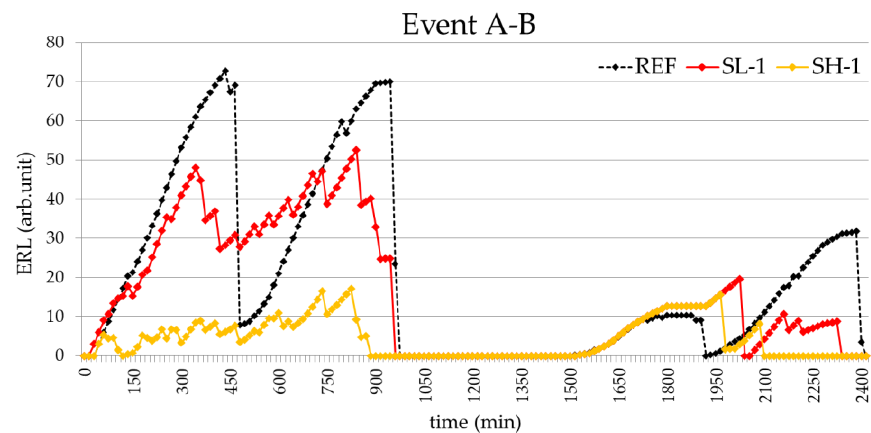
Figure 11. Calculated ERL during event A and event B.